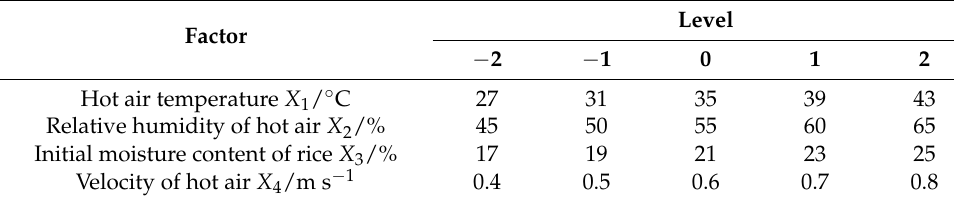
Table 2. Experimental factors and their